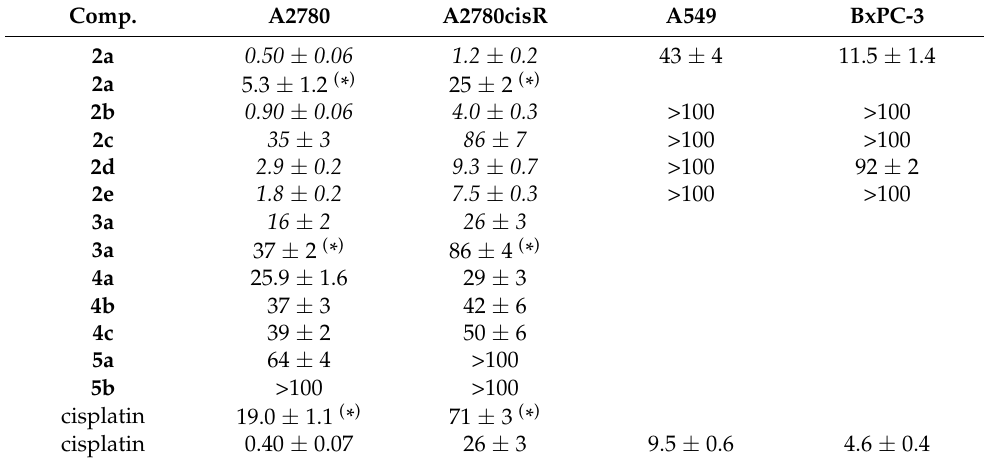
Table 1. IC 50 values ( µ M) determined for iron complexes and cisplatin on cell lines after 72 h exposure, unless otherwise specified. Values are given as the mean ± SD. Italic: previously reported data from ref. [20]. ( * ) Exposure time: 24 h. Comp.